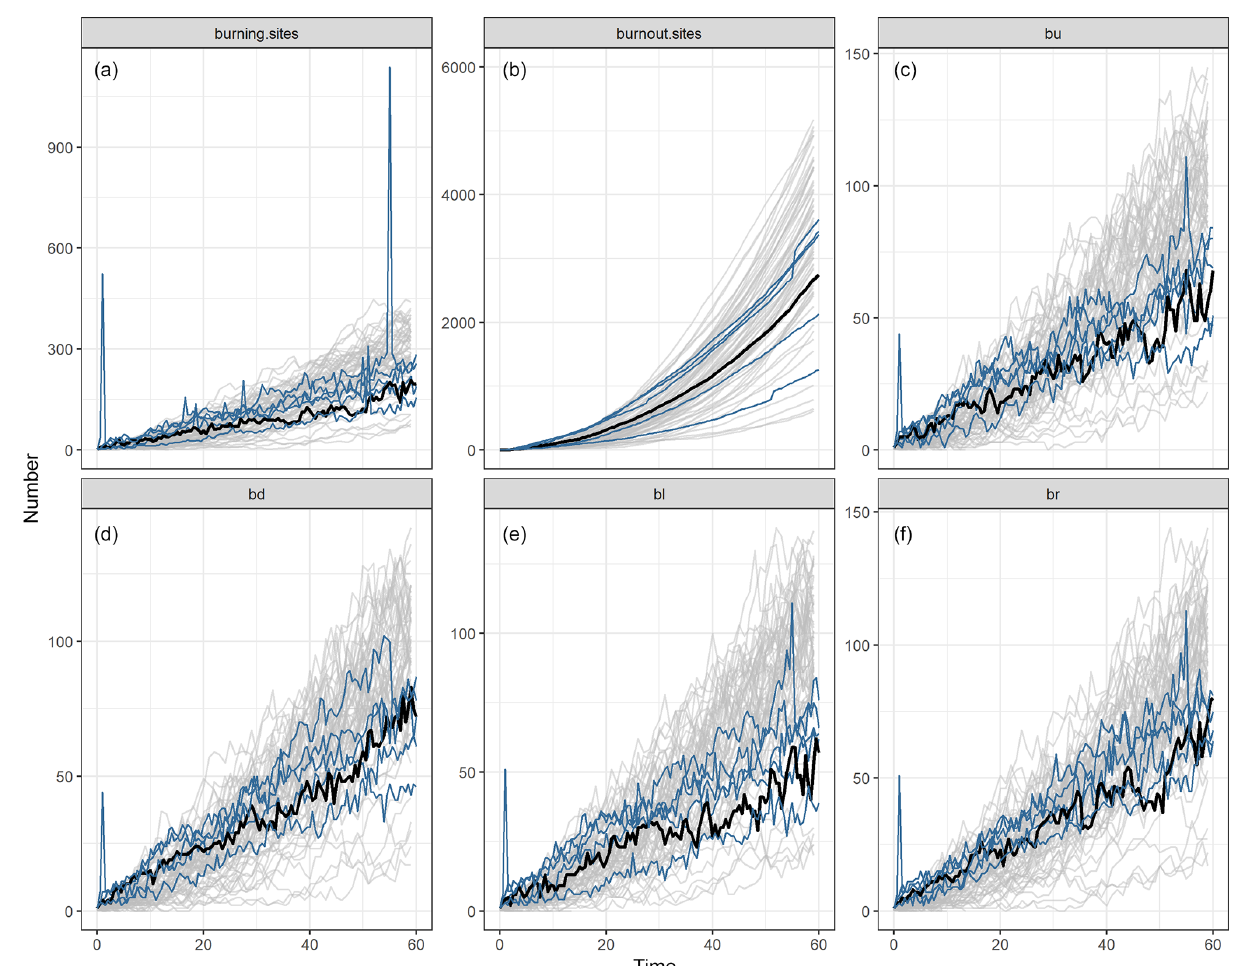
Figure 6. Comparisons between data from 100 simulation runs and observed data from six microfires. (a) Number of simulated (grey) and observed (blue) burning sites versus time; (b) number of simulated (grey) and observed (blue) burnt-out sites versus time; (c–f) number of simulated (grey) and observed (blue) neighbourhood counts versus time. The black curve in each panel corresponds to the observed data from the third microfire, upon which the estimates of µ and λ underlying the simulated data are